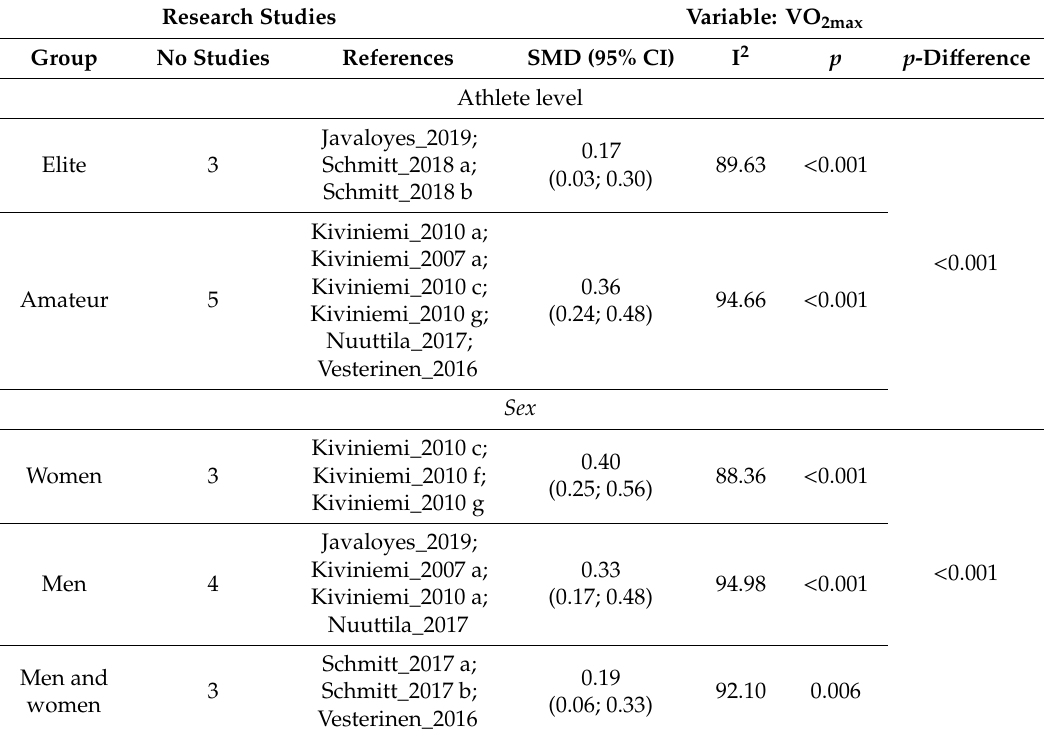
Table 3. Subgroup analyses for measuring their impact on VO 2max .